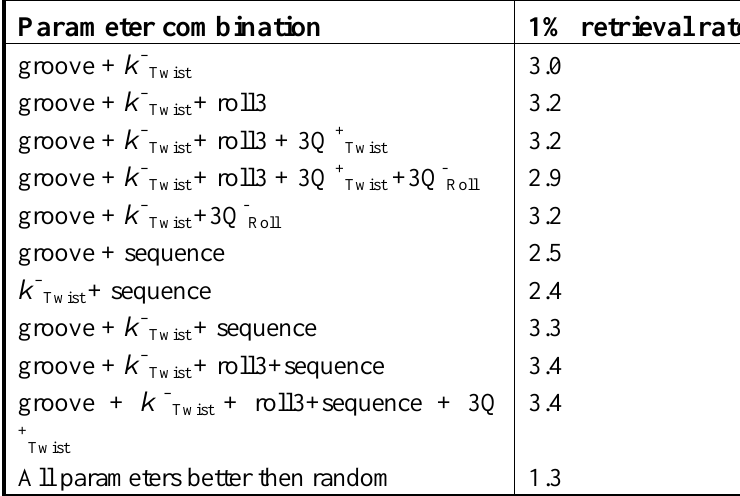
(red); sequence, Twist + roll3 (black); Twist